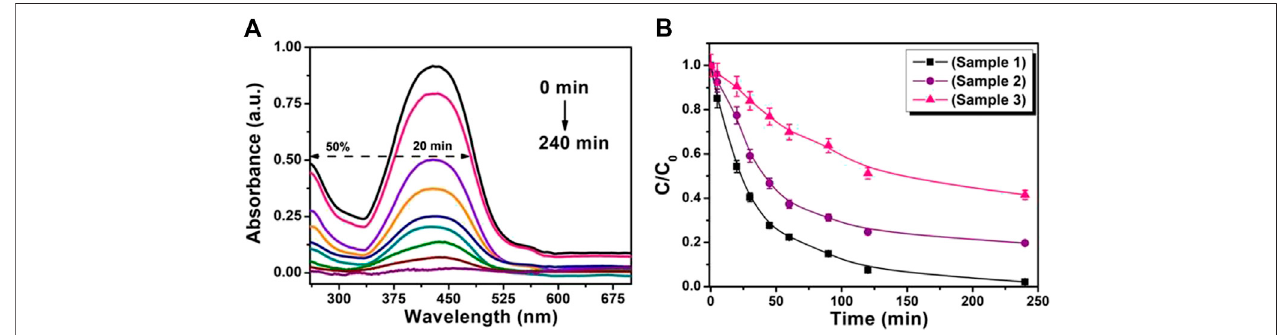
FIGURE 5 | (A) Kinetic relationship of ln (C 0 /C) vs. irradiation time, for various ZnO nanosheet photocatalysts. (B) Plot of rate constant vs thickness of nanosheets. (C) The stability of ZnO nanosheets (sample 1) for photodegradation of MR.